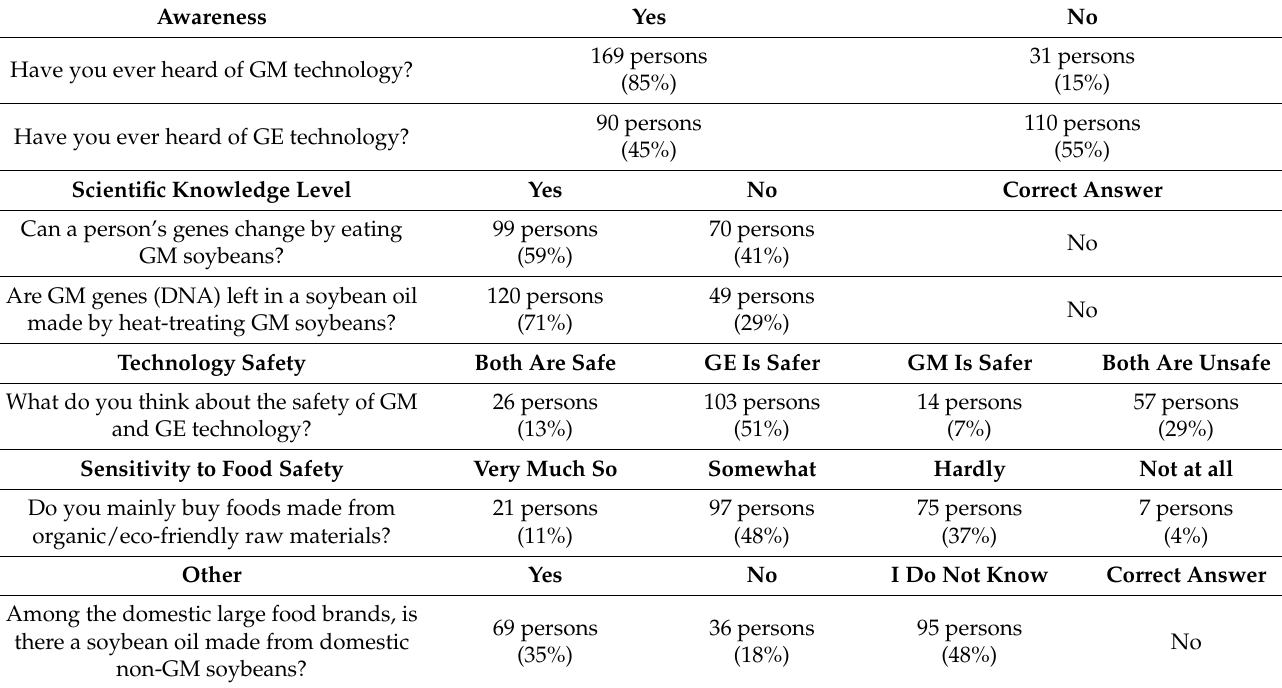
Table 5. Survey results of respondents’ general